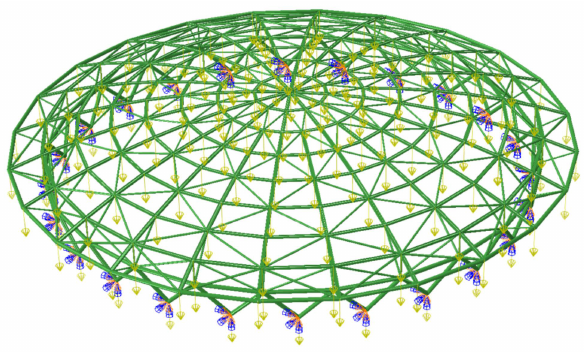
Figure 7. ABAQUS finite element